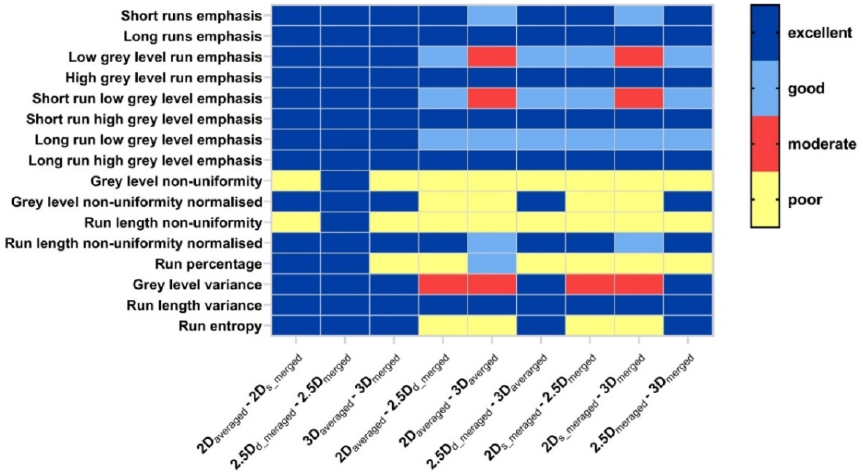
Figure 5. ICC heat map of GLRLM features; volumes: pair-wise aggregation methods corresponding to Figure 2; rows; GLCM features. Blue = ICC > 0.9 (excellent), light blue = 0.75 ≤ ICC < 0.9 (good), red = 0.5 ≤ ICC < 0.75 (moderate), yellow = ICC < 0.5 (poor).